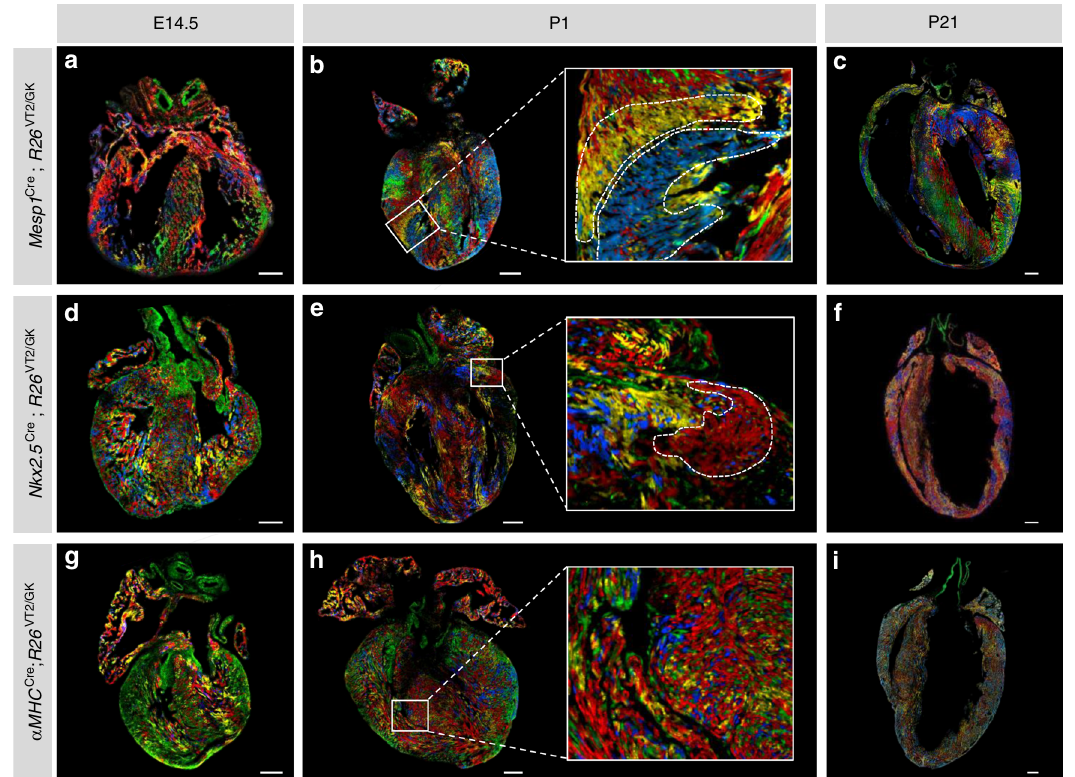
Fig. 1 Evidence of clonal expansion during cardiac development. Representative fl uorescent microscope images of a – c , Mesp1 Cre ; R26 VT2/GK , d – f , Nkx2.5 Cre ; R26 VT2/GK , and g – i , α MHC Cre ; R26 VT2/GK longitudinal hearts sections at E14.5, P1, and P21 respectively ( n = 4). Insets show a higher magni fi cation of boxed areas. Putative clonal areas are traced by a dotted line. Scale bar 500 μ m ( c , f , i ), all others 50 μ